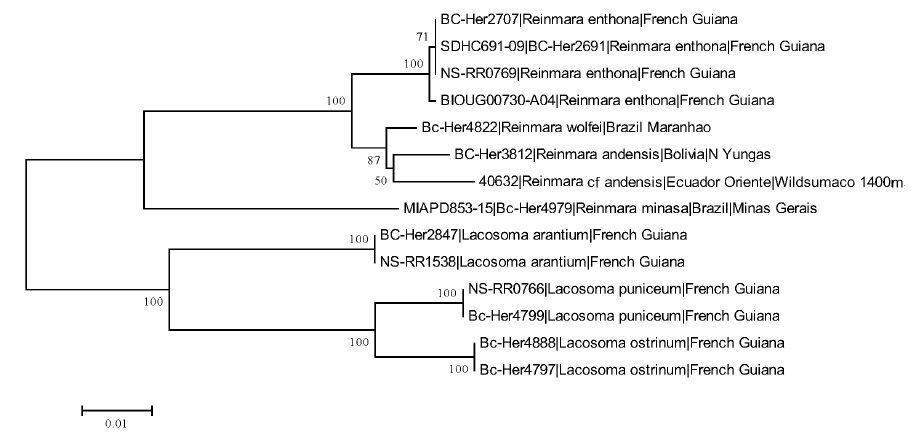
Figure 7. Phylogenetic tree built with neighbor-joining method in MEGA6 showing relationships among Reinmara , with Lacosoma Grote, 1864 as the outgroup. See remarks section for R. andensis regarding noted issues with this